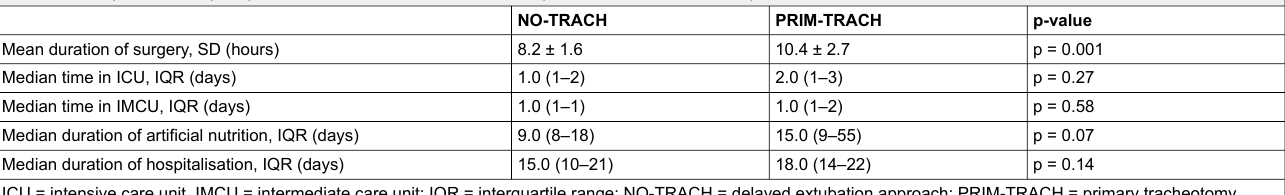
Table 2: Intraoperative and perioperative characteristics for NO-TRACH patients and PRIM-TRACH patients.